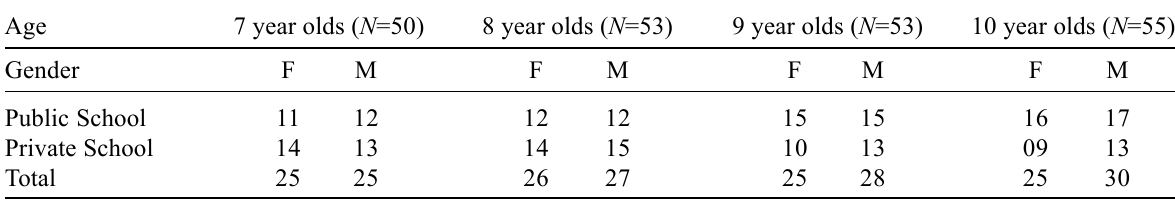
Distribution of the Sample (N=211) by Age, Gender and School Origin